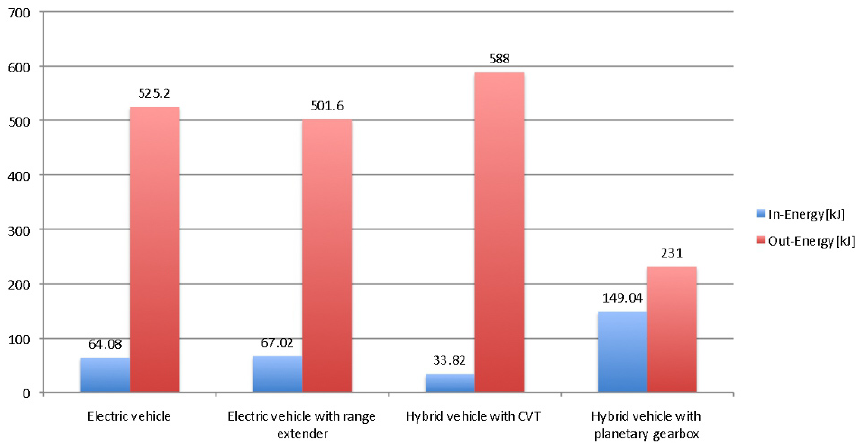
Figure 10. The cumulated value of the energy reached by the battery on a ECE-15